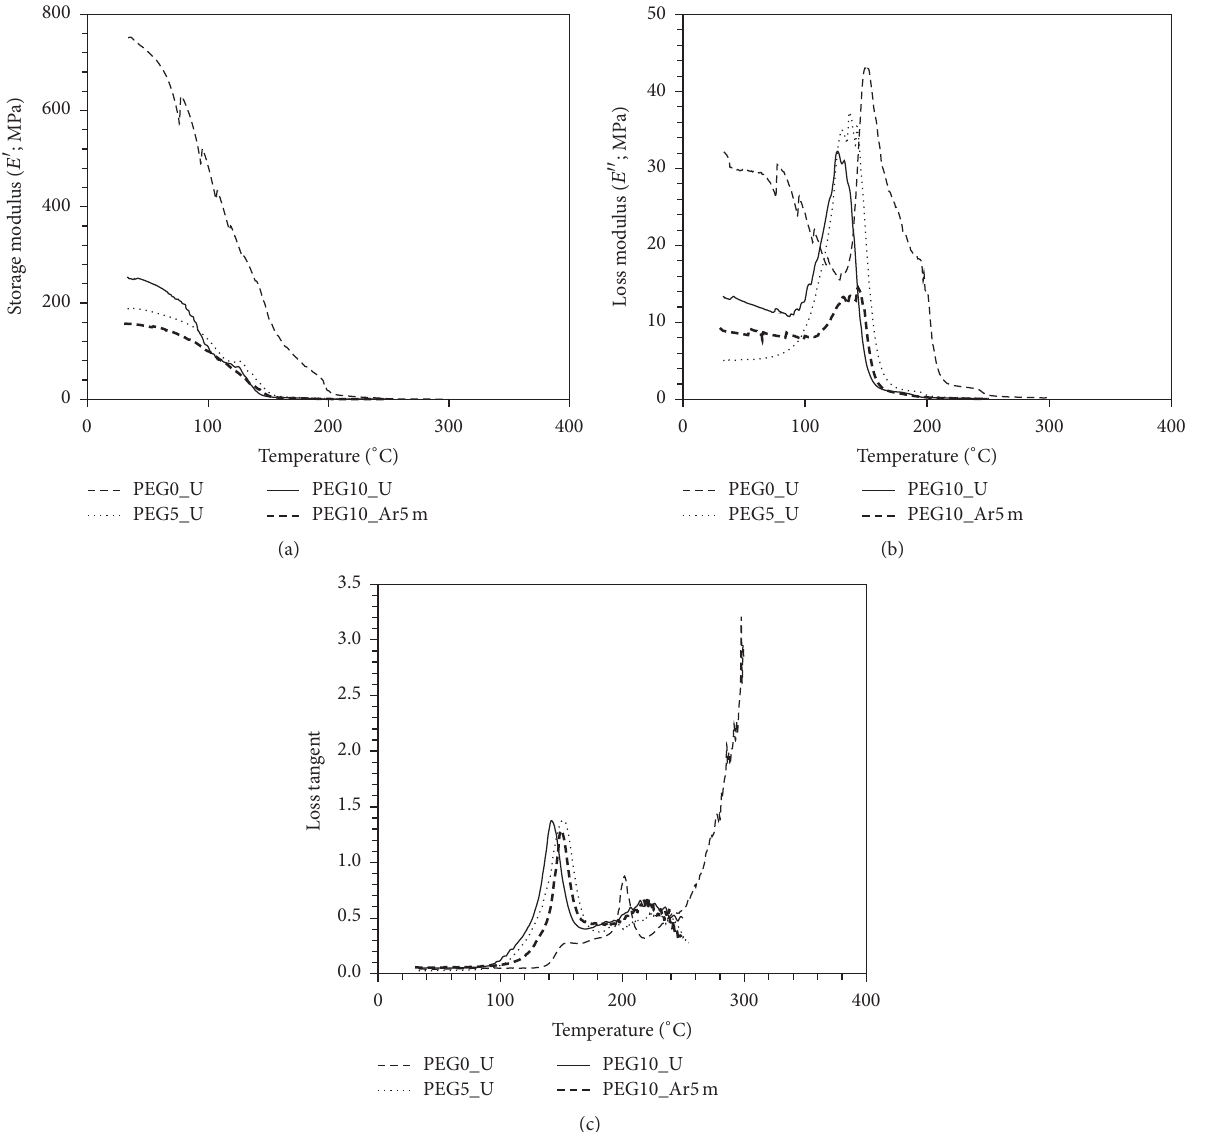
Figure 6: Variation of storage and loss modulus, loss tangent, and 𝑇 𝑔 of membrane samples with PEG concentration